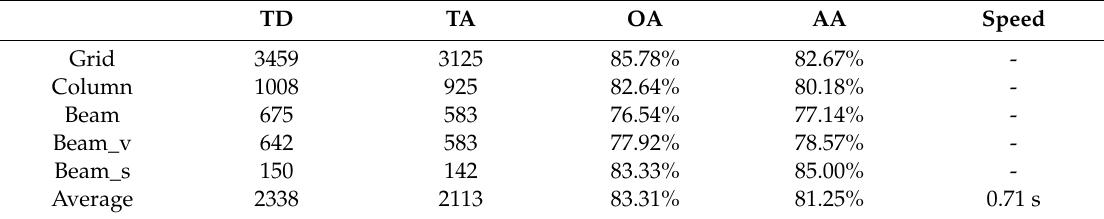
Table 5. TD, TA, OA, AA, and speed for di ff erent objects in test set.